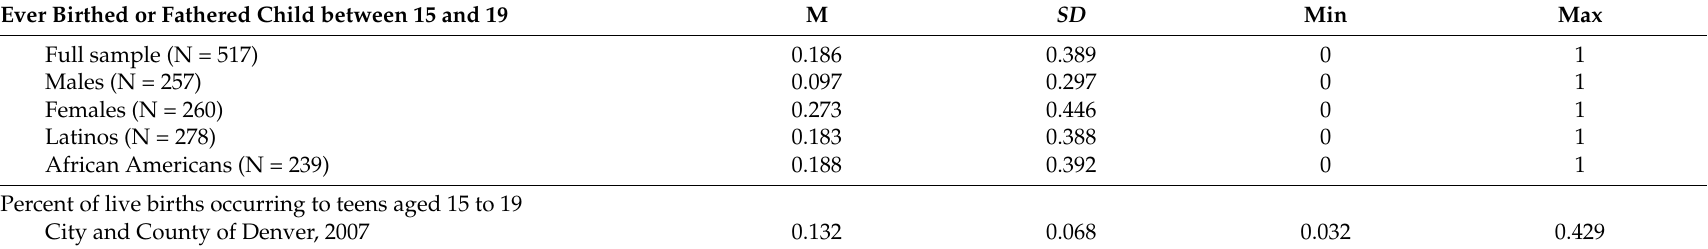
Table 2. Prevalence and Age of Teen Childbearing/Fathering a for Denver Child Study Samples and Denver, Colorado, 2007 b . Ever Birthed or Fathered Child between 15 and 19 M SD Min Max Full sample (N = 517) 0.186 0.389 0 1 Males (N = 257) 0.097 0.297 0 1 Females (N = 260) 0.273 0.446 0 1 Latinos (N = 278) 0.183 0.388 0 1 African Americans (N = 239) 0.188 0.392 0 1 0.132